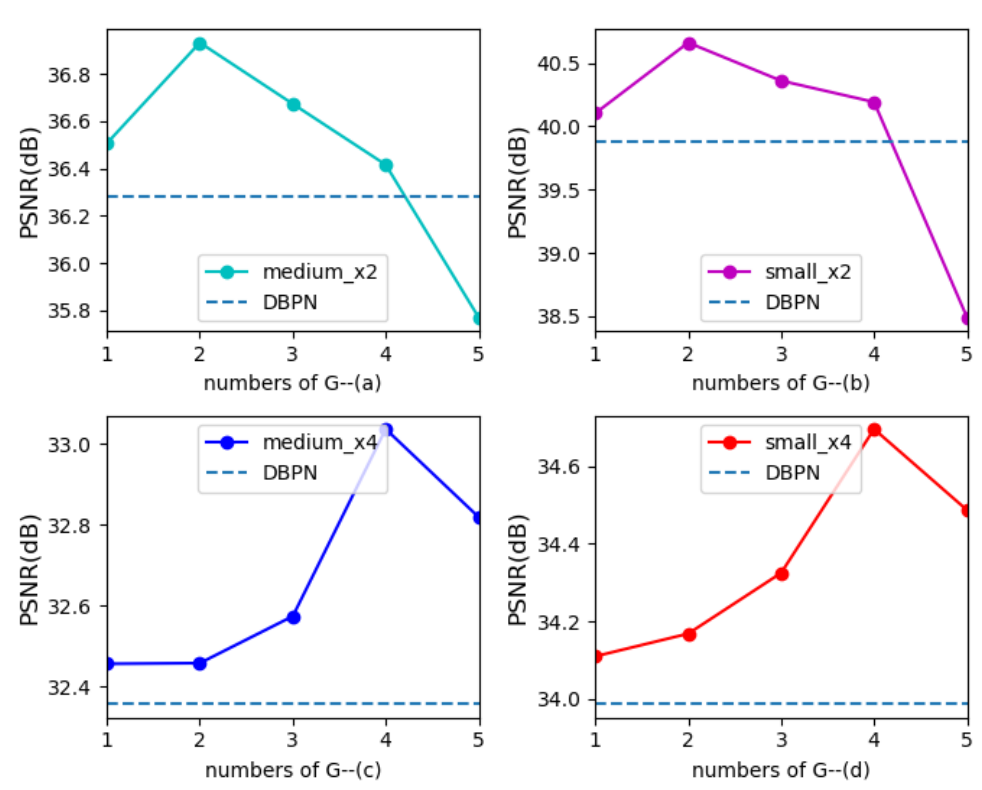
Figure 8. Five groups of comparative experimental PSNR